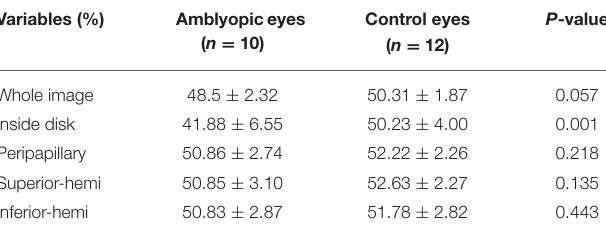
TABLE 4 | Peripapillary capillary small vessel density in amblyopic and control subjects.